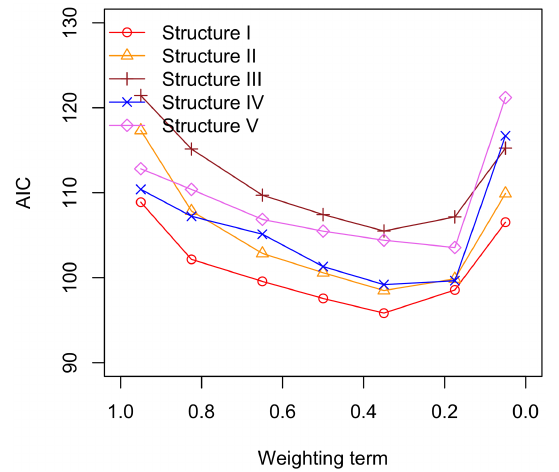
Figure 2. Average of the RMSE among all the three treatments for the five model structures with the variation of the relative weight of SO 14 C over total C. In this scale 1 means only total C, 0 means only SO 14